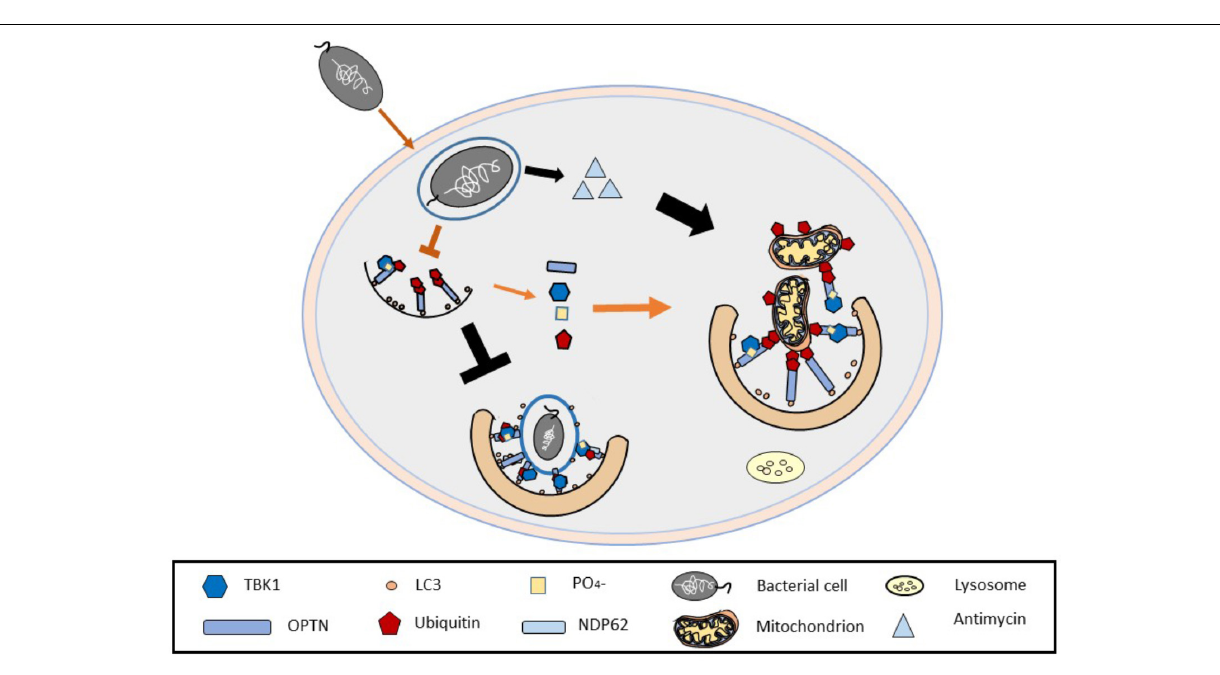
FIGURE 3 | Undermining mitochondria to establish bacterial infections. The figure depicts the ability of certain bacterial species to release mitochondria impairing toxins (i.e., antimycin to impair mitochondria) which upregulate mitophagy, perhaps as a way to hijack the common molecules used in both autophagy processes and as such allow the bacteria to propagate within the host